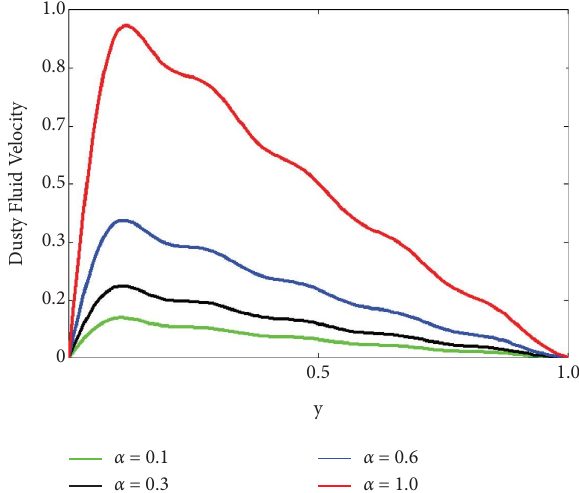
Figure 3: Te impact of diferent values of α on ψ